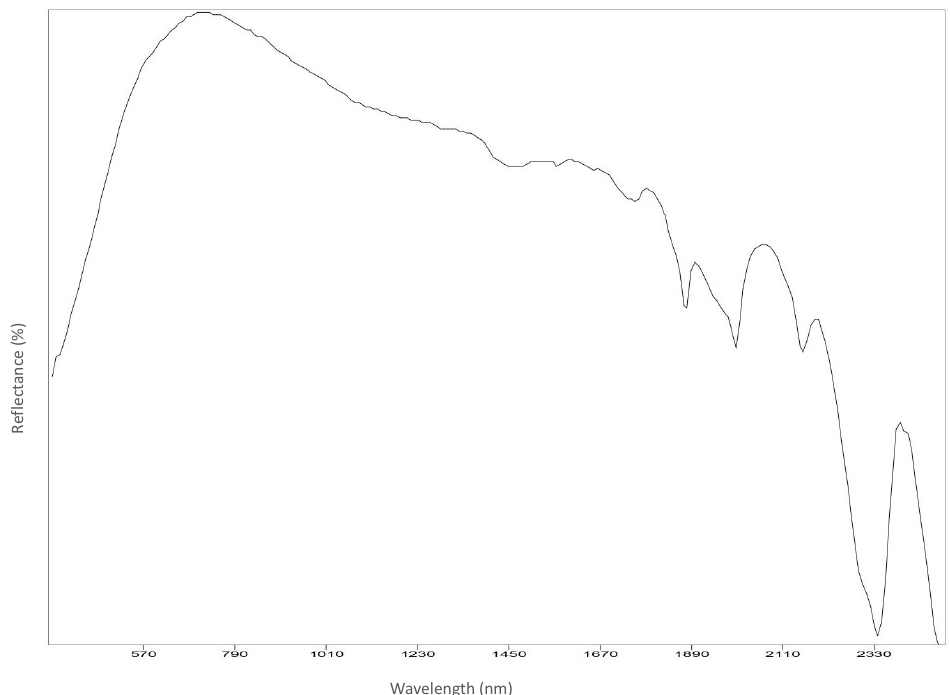
UV-vis-NIR Reflectance spectroscopy of measure points.